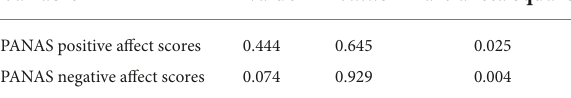
TABLE 6 Repeated measures ANOVA effect of time by condition on affect.